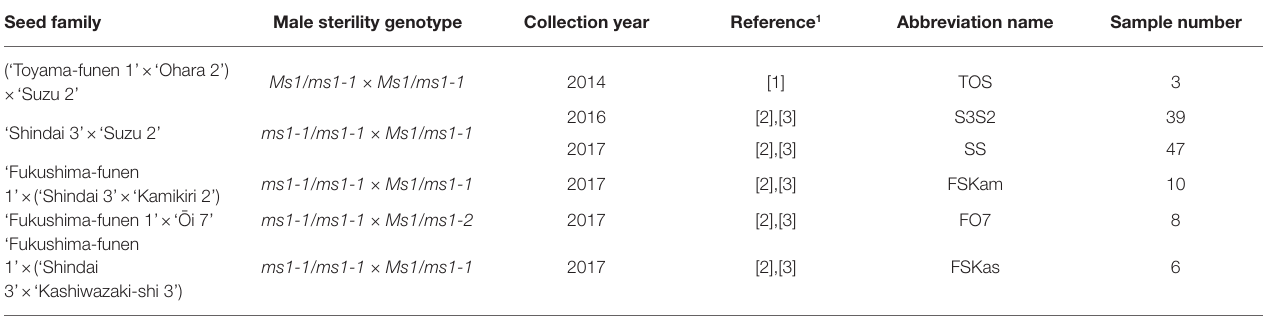
TABLE 1 | Sugi seed families carrying the male-sterility gene MS1 used as main experimental plant material. Seed